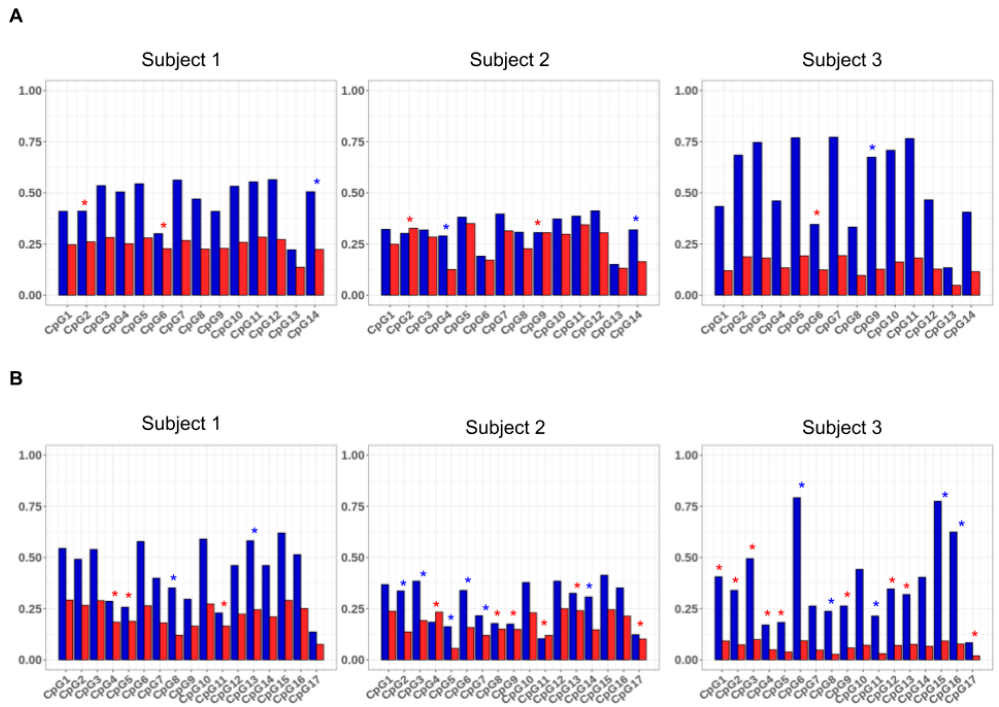
Figure 5. Allelic average methylation of the AR (A) and GLA (B) CpG dinucleotides. For a specific CpG, the allele average methylation was calculated as the number of times the CpG was methylated on the allele compared to the total number of epialleles. CpGs with a significant difference in the average methylation between the two alleles are indicated ( Χ 2 with Bonferroni–Holm post-hoc test p -values <0.01 ) with an asterisk. The color of the asterisks indicates the allele with a positive residual from the post-hoc test (more methylated). Blue asterisks: CpGs with post-hoc test p -value <0.01 and with a positive residual for the paternal allele. Red asterisks: CpGs with post-hoc test p -value <0.01 and with a positive residual for the maternal allele.